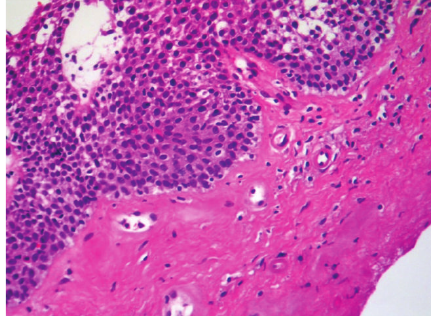
Figure 2: Histological analysis of esophageal biopsy showing dep- osition of eosinophilic hyaline material in the lamina propria and around blood vessels (hematoxylin and eosin